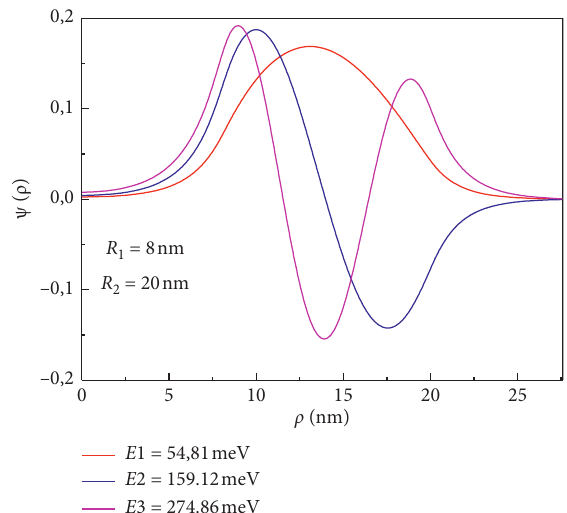
Figure 14: The dependence of the radial wave function of an electron on the radius of a cylindrical quantum nanorod with a finite potential.